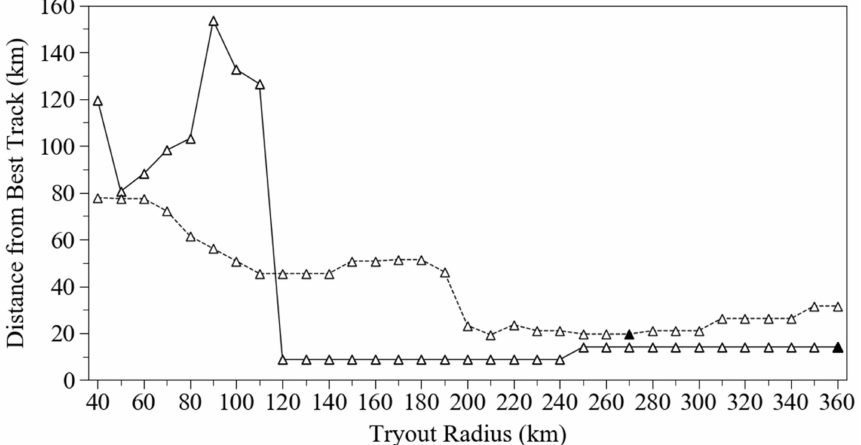
Figure 3. Variations of the distance between the best track center and the ABI-determined TC center when R i is varied from 40 to 360 km at about 1200 UTC September 4, 2017 (solid curve) and 1800 UTC August 30, 2017 (dashed curve). The objectively determined R i values of 270 and 360 km (solid triangles) are indicated by solid triangle